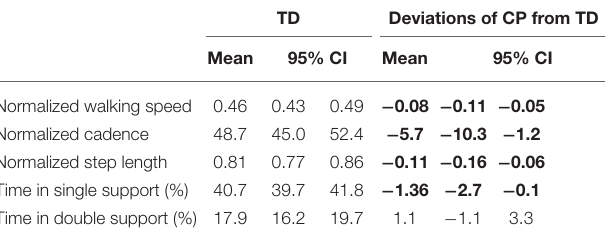
a coactivation index of 100% represents equal activity of the TABLE 2 | Spatiotemporal gait parameters of the healthy legs of typically developing children (TD) and the deviation of the affected legs of children with cerebral palsy (CP) from TD, presented as mean with 95% confidence interval